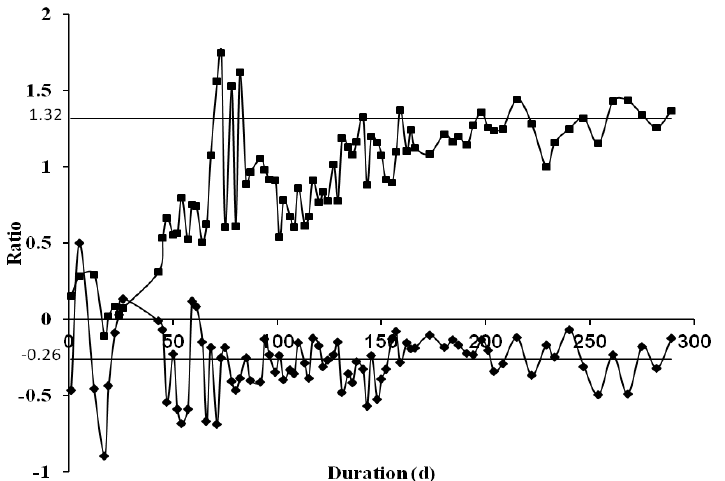
Figure 7. Performance of ANAMMOX biomass cultivation ( ■ : ratios of consumed NO 2− -N to consumed NH 4+ -N; ♦ : ratios of generated NO 3− -N to consumed NH 4+ -N).